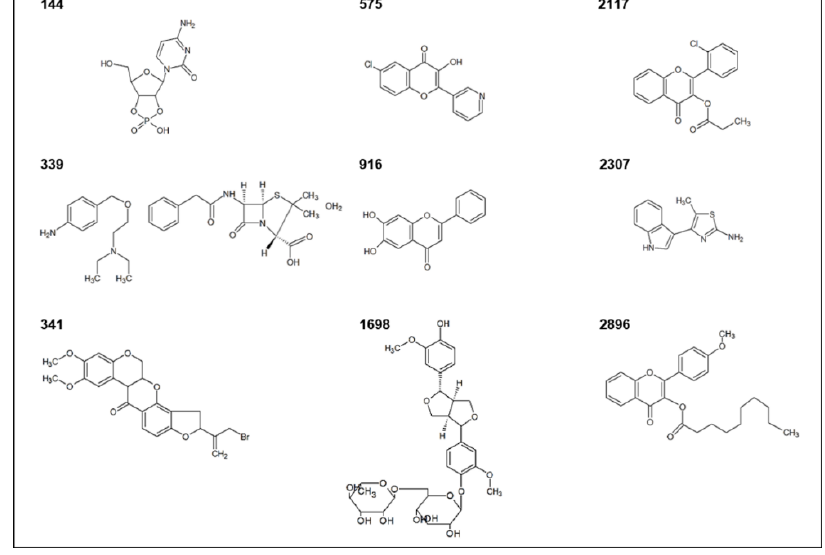
Figure 3. Structures of the highly active QSIs identified in the primary screening. The structures are drawn using ACD/ChemSketch software. The IUPAC names of the compounds are listed in Table S4.